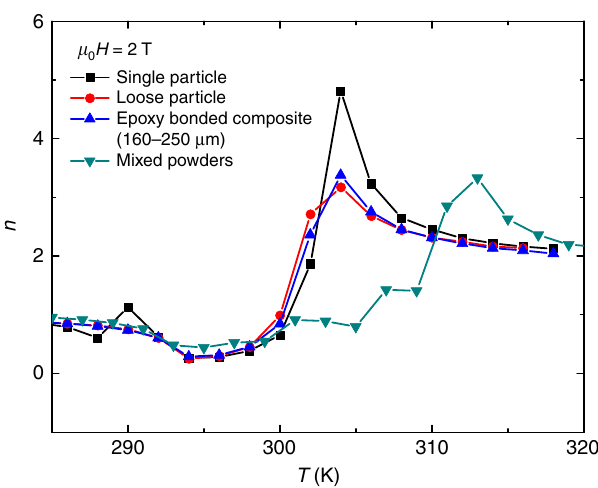
Fig. 8 In fl uence of distributed transition temperatures on exponent n . The materials used for this example consist of a single LaFeSi-type particle and different LaFeSi-based composite materials. In all cases, the overshoot of n > 2 is observed, in agreement with their FOPT nature